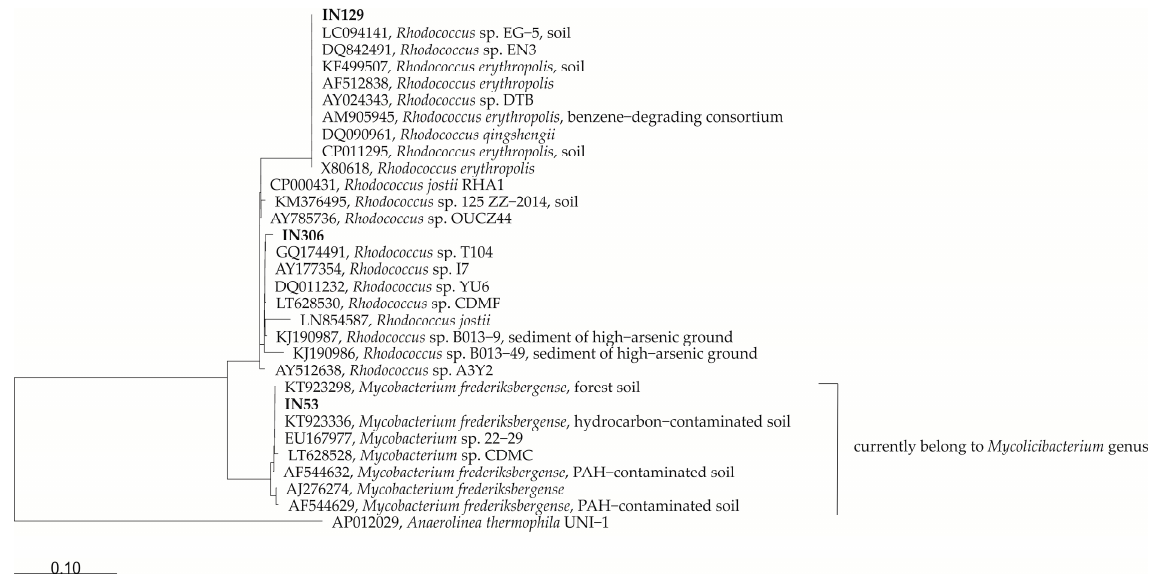
Figure 1. Phylogenetic consensus tree of the stains IN129, IN53 and IN306 with closely related sequences from the NCBI GenBank database. GenBank accession numbers are shown in the Figure. The scale bar corresponds to 10% estimated sequence divergence.